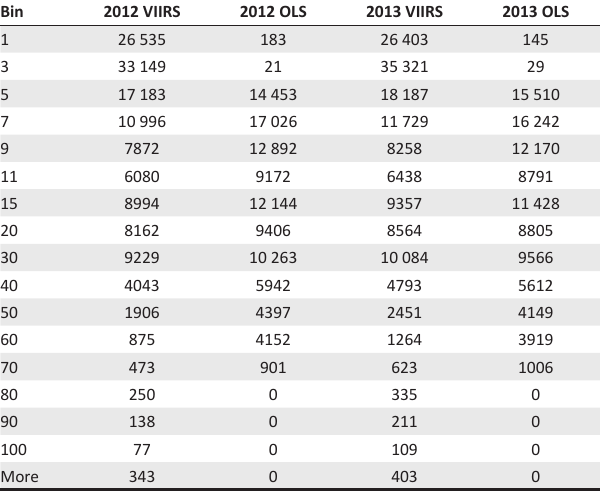
TABLE 3: Frequency distribution of the digital number pixels with a value greater than 0 for the period 2012 and 2013. Bin